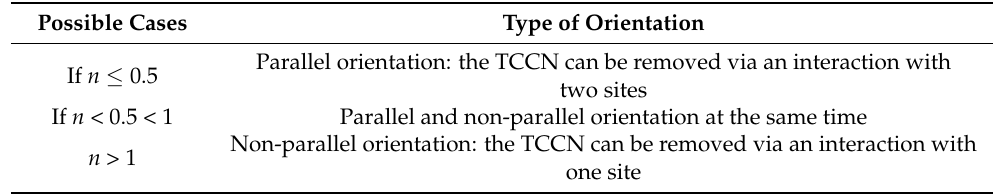
Table 2. Possible cases to describe the TCCN orientation on both adsorbents.